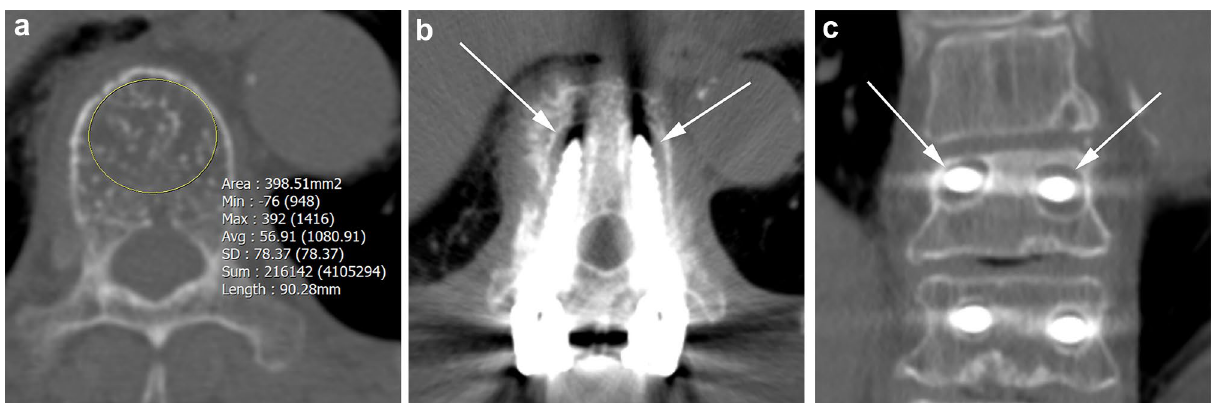
Figure 4. A 76-year-old woman who underwent spinal fusion surgery from T10 to S1. In the axial plane of the preoperative CT scan ( a ), the Hounsfield unit value of the upper instrumented vertebral body (T10) was 56.91, which was lower than the cutoff value. Postoperative CT images performed 1 year after surgery revealed bilateral pedicle screw loosening in both the axial ( b ) and coronal ( c ) planes (arrows). min minimum, max maximum, avg average, SD standard